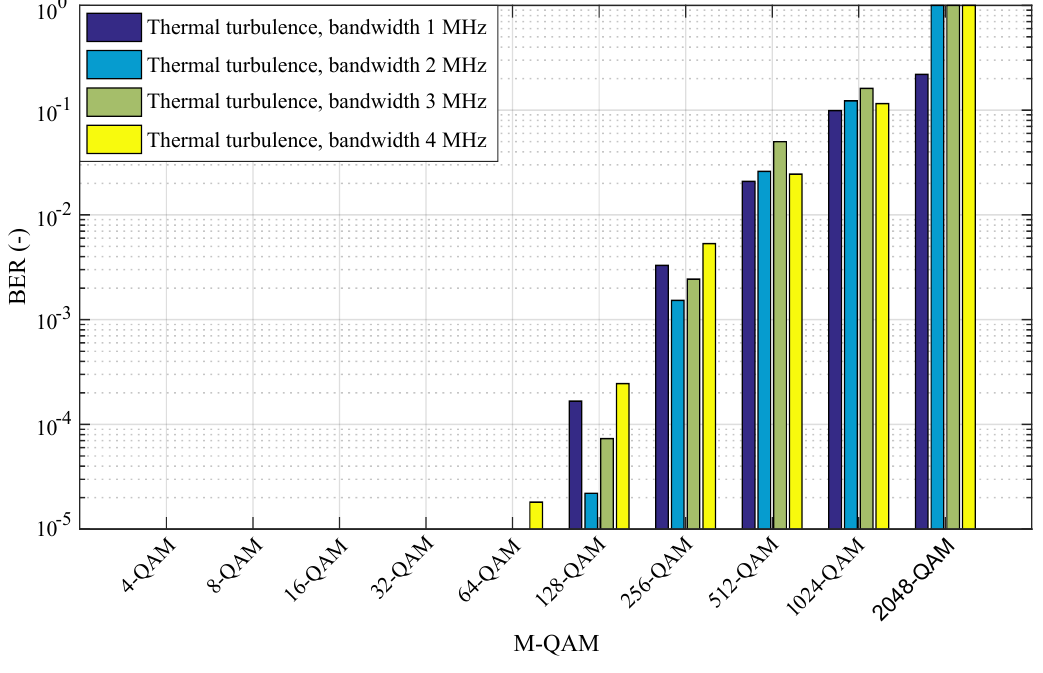
Figure 19. BER/distance relationship for Octavia tail-light with different M-QAM and bandwidths—scenario 2—thermal turbulence.